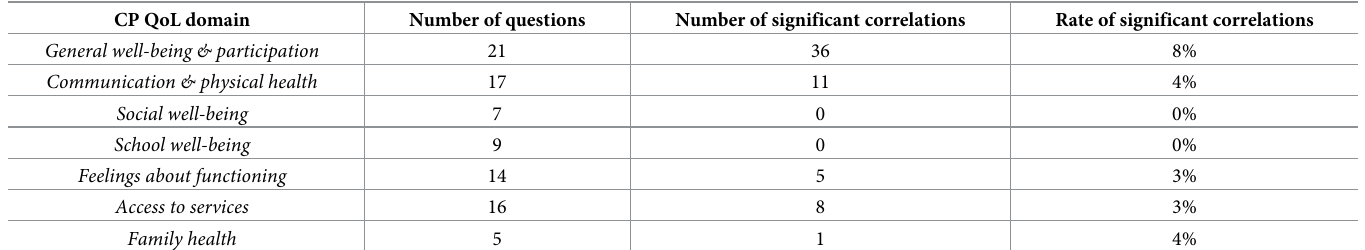
Table 4. Differences between parents’ domains from Hungary and Pannonian basin.